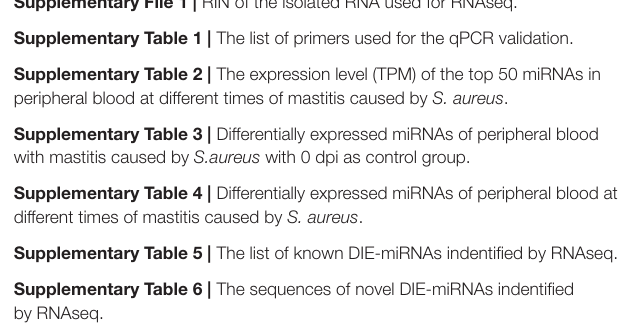
Supplementary Table 1 | The list of primers used for the qPCR validation.